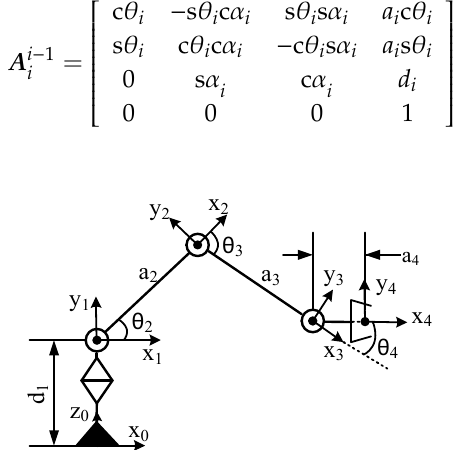
Figure 12. Coordinate system of the manipulator. Table 1. D-H parameter table of the manipulator.